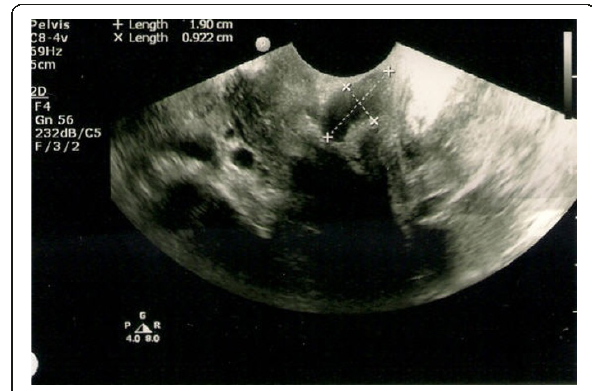
Figure 1 Pelvic ultrasound at the 17 th week of pregnancy .